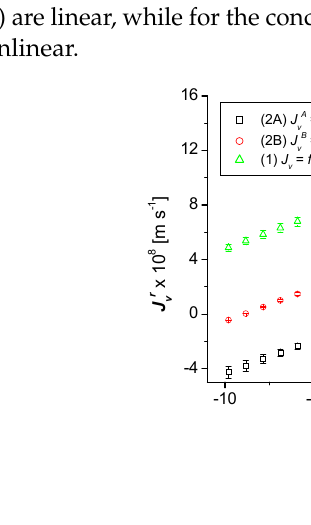
Figure 2. Volume fluxes ( J r v ) as function of ( a ) the osmotic pressure of glucose pressure difference ( ∆ π 1 ) with a constant osmotic pressure difference of ethanol ( ∆ π 2 = 490.2 kPa) and ∆ P = 0 for stirred solutions (1A, 1B) and not stirred solutions (2A, 2B), ( b ) the hydrostatic pressure difference ( ∆ P ) with a constant osmotic pressure difference of both glucose ( ∆ π 1 = 96.8 kPa) and ethanol ( ∆ π 2 = 490.2 kPa) for stirred solutions (1A, 1B) and not stirred solutions (2A, 2B).